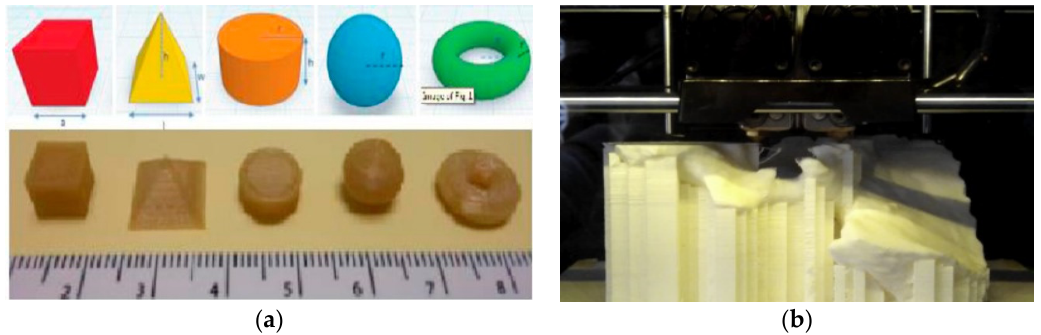
Figure 4. ( a ) 3D representation and images of the 3D geometries printed using the FDM process [38] ( b ) 3D printing of an acetabulum through Fused Deposition Modelling (FDM) with acrylonitrile butadiene styrene (ABS) polymer [39]. Reprinted with permission from References [38,39]. Copyright 2017, Elsevier, and 2016,